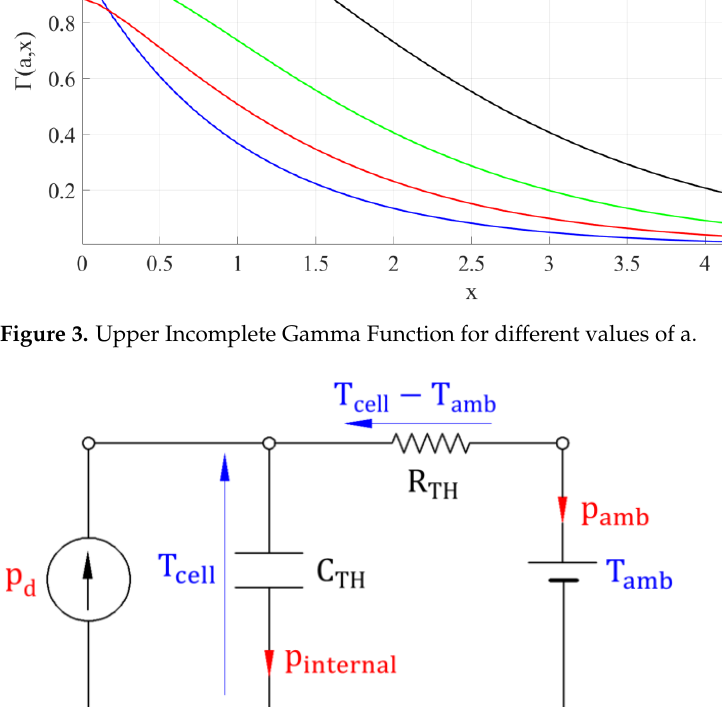
Figure 3. Upper Incomplete Gamma Function for different values of a.